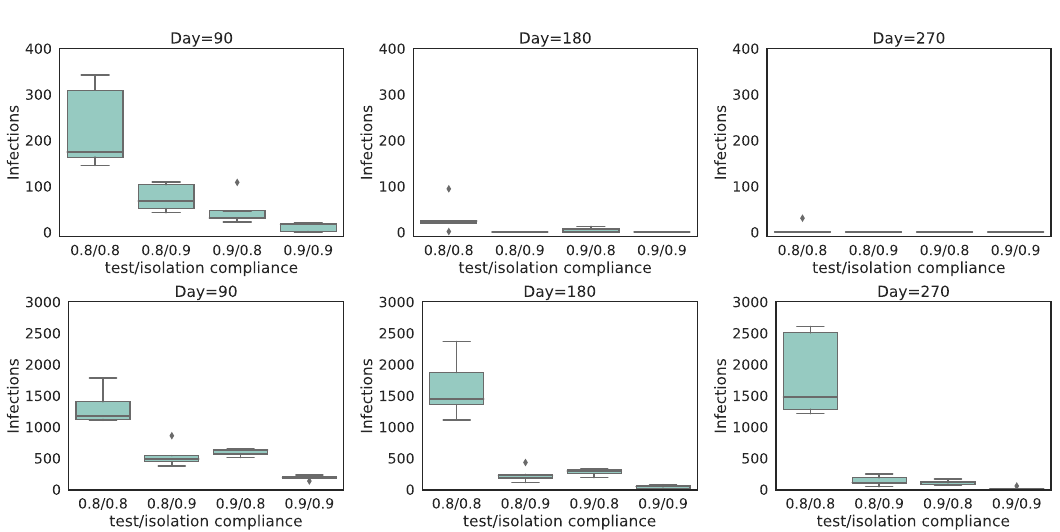
Fig 3. Distribution of the number of infections for the experiments when the lock-down ends on the first of July, in different scenarios of compliance for testing and isolation. We show results for the pool isolation strategy (top panels) and individual based isolation strategy (bottom panels). We show the number of infections at three different time points. i.e., 90 days (left panels), 180 days (middle panels) and 270 days (right panels) after the start of the universal testing procedure. These results consider a weekly universal testing procedure (i.e., k = 32 and T = 50000) and a FNR PCR = 0.1. Each box represents a combination of test and isolation d compliance.